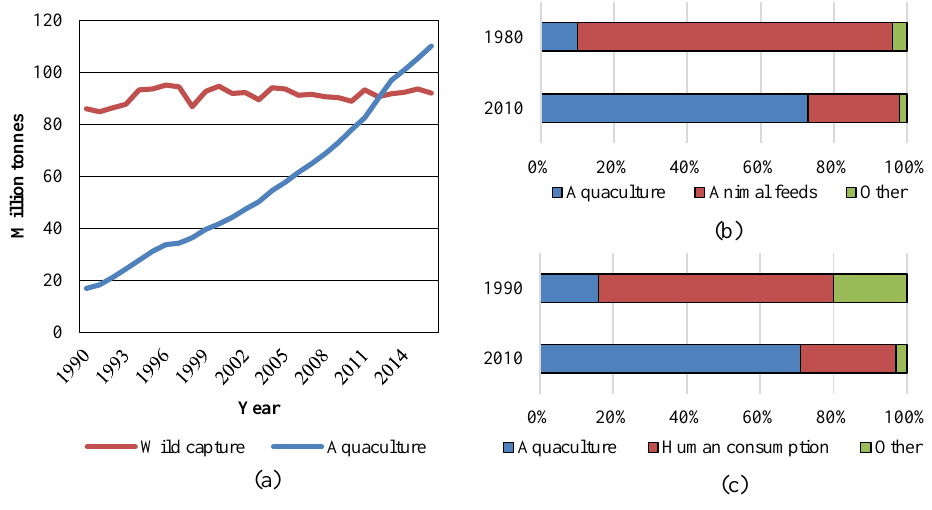
Fig. 1. (a) Change of global production volumes of aquacultures and wild capture fisheries [2]; (b) changing uses of fish meal [3]; (c) changing uses of fish oil [3]. 2. S HORTAGE OF F ISH M EAL AND F ISH O